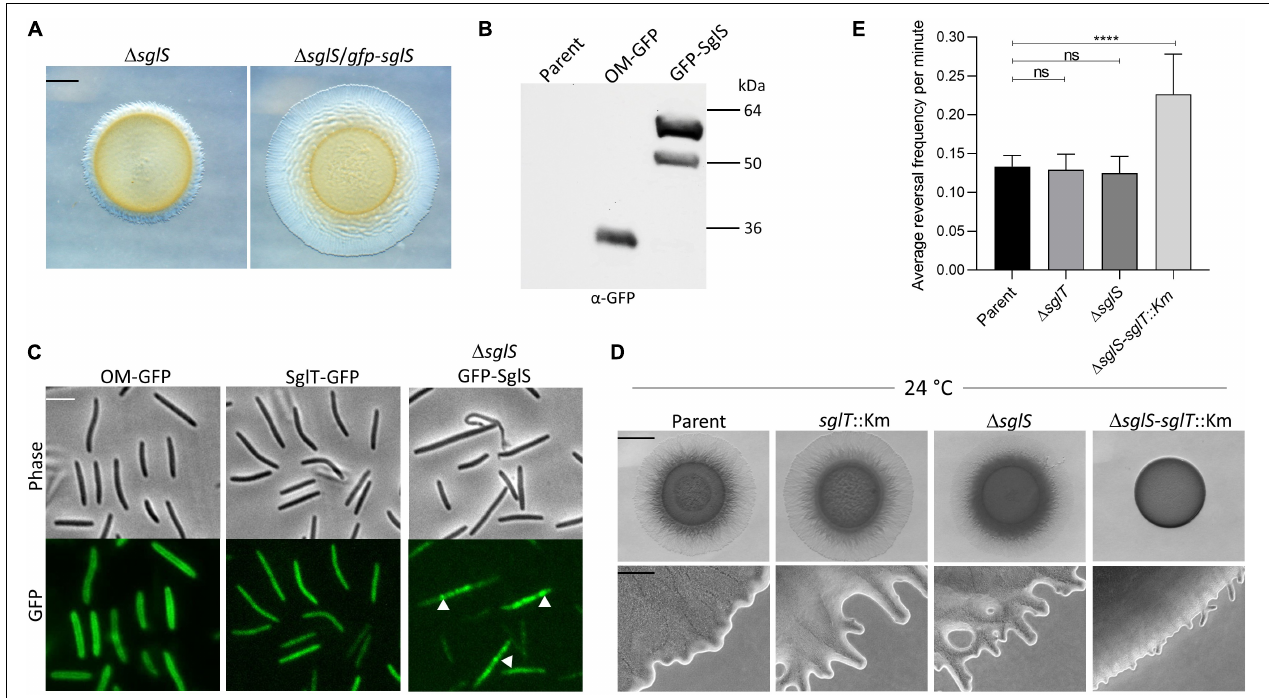
FIGURE 4 | SglS and SglT localization and double mutant phenotype in DK1217 backgrounds. (A) The GFP-SglS fusion restores (complements) the S-motility defect caused by a (cid:49) sglS mutation at 33 ◦ C on 0.5% agar. Scale bar, 2 mm. (B) Immunoblot shows the GFP-SglS fusion stably expressed at a predicted size of ∼ 50 kDa. Nature of higher mobility band unknown. OM-GFP is a lipoprotein fusion and serves as a control (Cao and Wall, 2017). Right, molecular weight markers. (C) Phase contrast and fluorescence microscopy images shows SglT-GFP (Troselj et al., 2020) uniformly localized in cytoplasm, while GFP-SglS forms puncta in the cytosol (white triangles), which are dynamic (see Supplementary Video 5 ). Scale bar, 5 µ m. (D) Epistasis tests. (cid:49) sglS-sglT:: Km exhibits severe S-motility defect at 24 ◦ C, while single mutants exhibit WT motility. Plates incubated for 72 h. Scale bars, 2 mm and 200 µ m. (E) Reversal frequencies averages for (cid:49) sglS-sglT ::Km double mutant (reversal frequency 0.2267; 1 reversal per 4.7 min) compared to single mutants sglT (0.1292; 7.9 min), sglS (0.1250; 8.2 min) and parent strain (0.1333 or 7.6 min). *Note, only ∼ 5% of the double mutant moved and were scored for reversals, while for the other three strains nearly all of the cells were motile. Each strain cultured at 24 ◦ C, 20 individual cell reversals were tracked based on corresponding Supplementary Videos . ns, not statistically significant (p > 0.05); ****, p < 0.0001 as determined by One-Way ANOVA